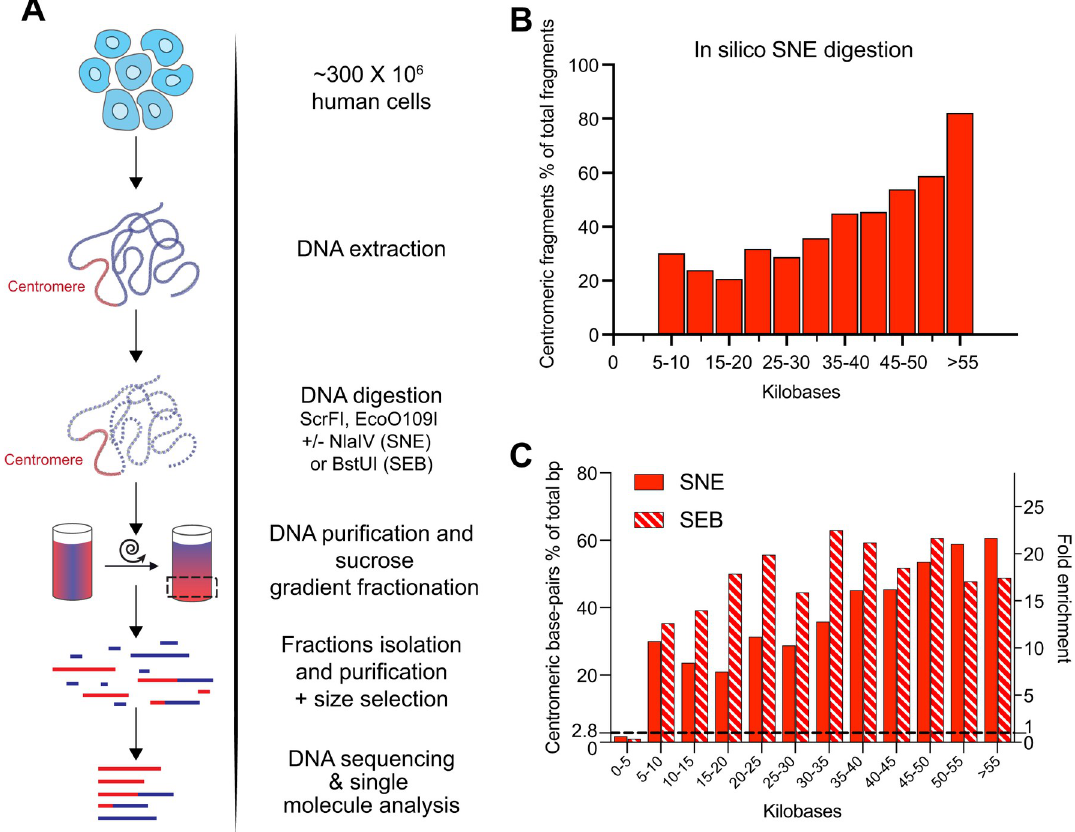
Fig 1. A restriction enzyme-based method to enrich and purify centromeric DNA from human cells. A . Schematic representation of the experimental design. B . Predicted distribution of the percentage of centromeric fragments in the indicated size bins after in silico digestion of the reference T2T-CHM13v1.0 genome with the SNE enzyme combination. Y-axis represents the percentage of centromeric fragments over total fragments in each length range. C . Distribution of centromeric base-pairs according to predicted fragment length after in silico digestion of the reference T2T-CHM13v1.0 genome with the SNE or SEB enzyme combinations. The y- axis on the left represents the percentage of centromeric base-pairs over total base-pairs in each length range. The dotted line at 2.8% represents the percentage of centromeric base-pairs in the reference genome, corresponding to the expected fraction of centromeric DNA in a theoretical non-enriched sample. The y-axis on the right reports the fold enrichment in centromeric base-pairs over the non- enriched sample (~2.8% of centromeric base-pairs in the reference